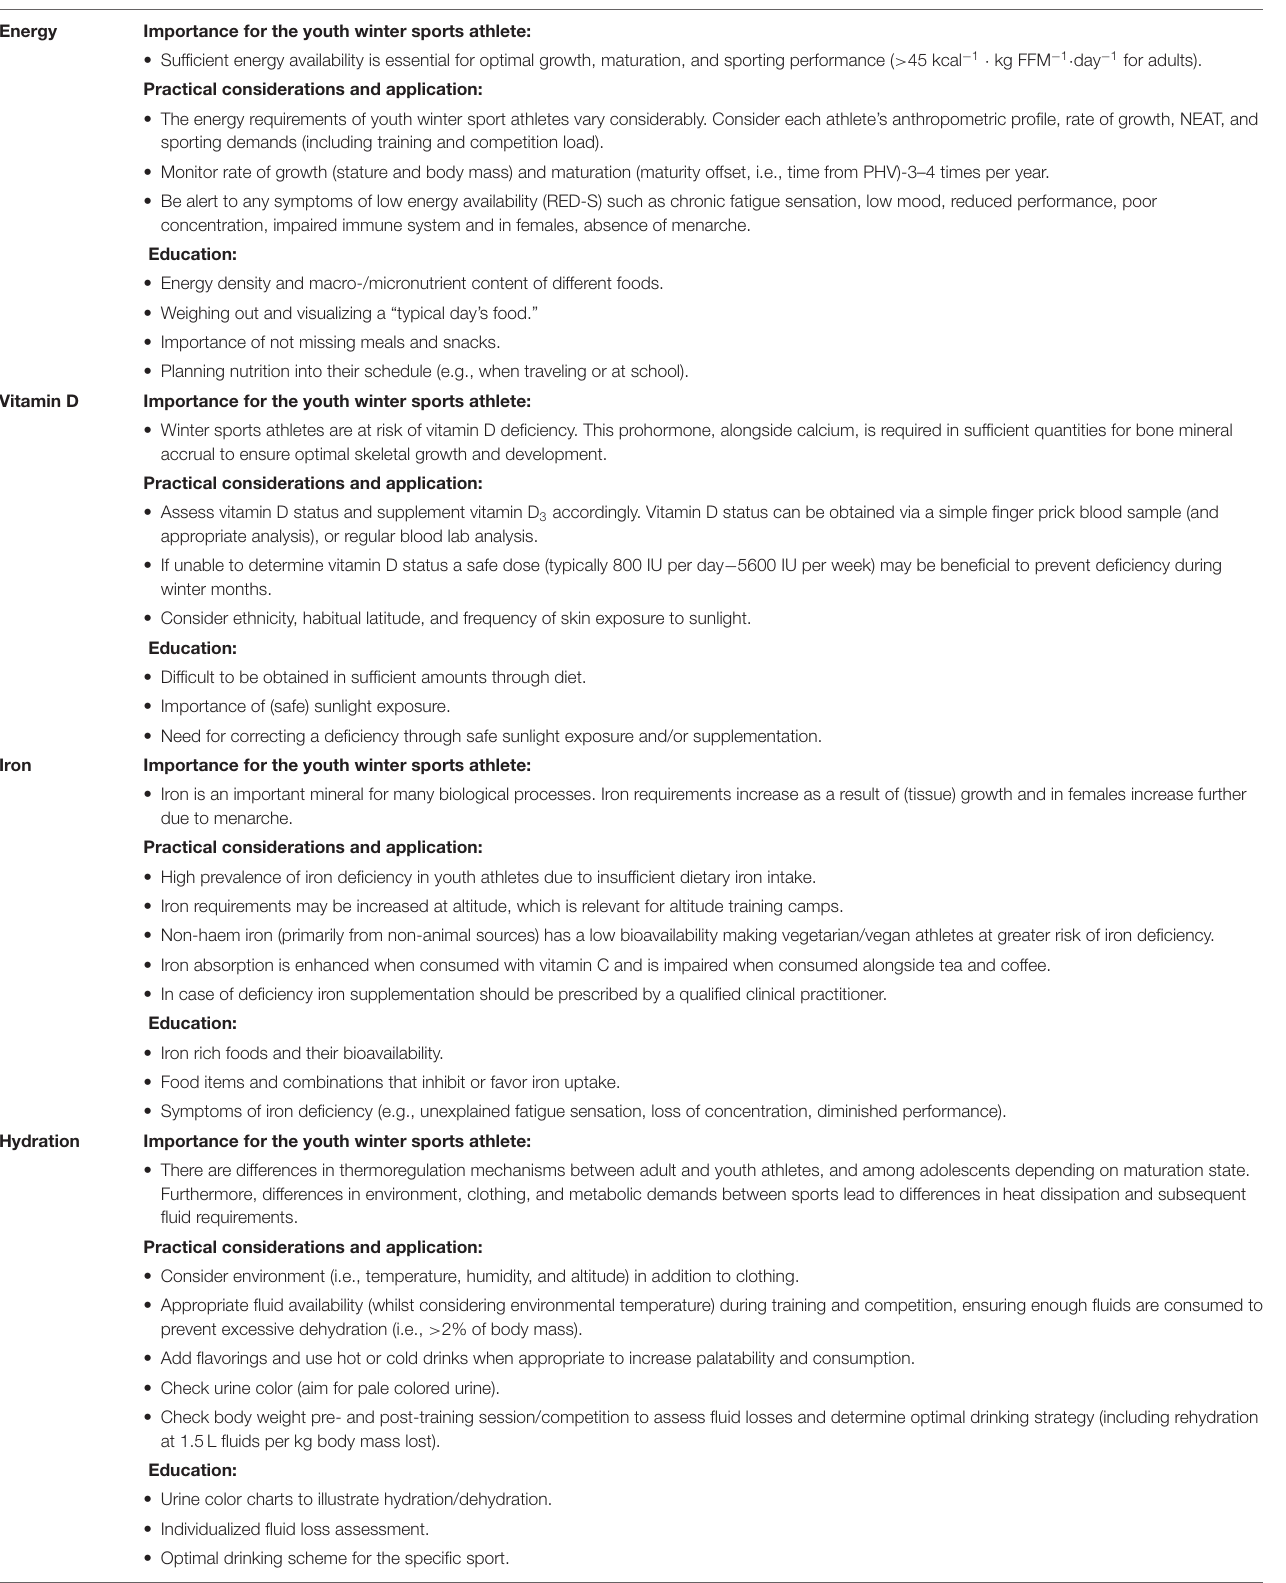
TABLE 1 | Key messages, practical considerations and important education messages on energy, vitamin D, iron and hydration for the youth winter sport